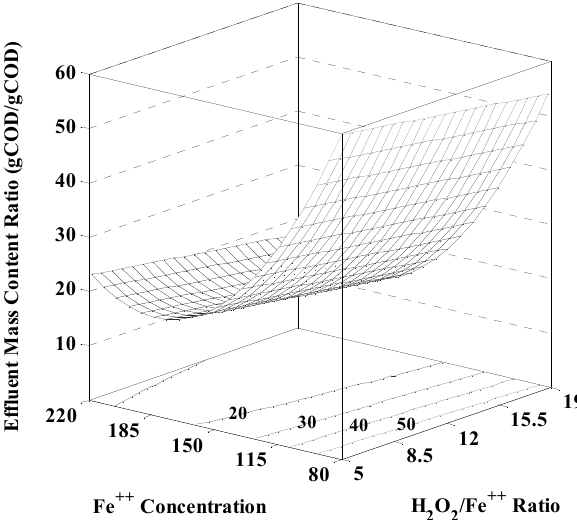
Fig. 3: MCR ( Y ). The response surface in terms of [H E 2 Fig. 3: MCR E ( Y 2 ). The response surface in terms of [H 2 O 2 ]/[Fe 2+ ] and Fe 2+ dosage (pH =